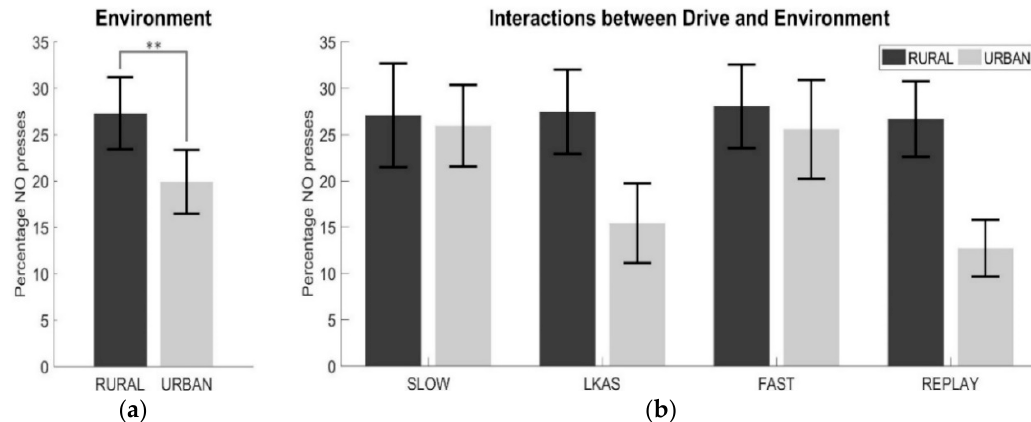
Figure 5. Percentage of NO presses: ( a ) across the two environments; ( b ) the interaction between these two factors is shown in the right graph. ** p ≤ 0.01. Error bars denote s.e.